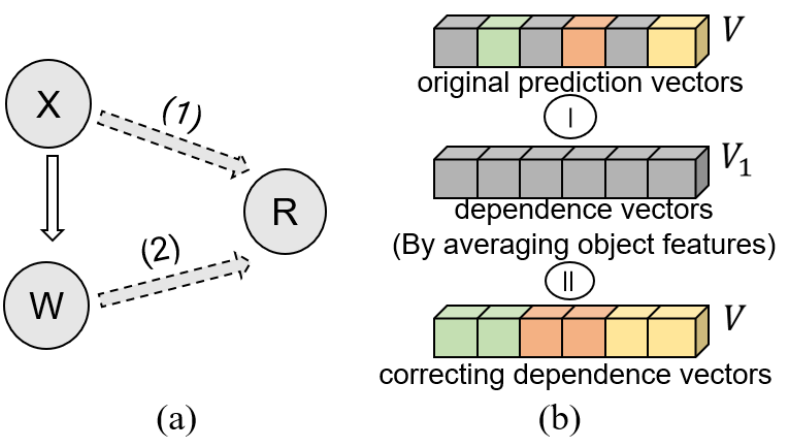
Figure 5. ( a ) Example of applying the object features and word vectors to predict object relationships, where X represents the visual features of the objects of interest, W represents the corresponding word vector in the external knowledge base, and R represents the prediction. ( b ) The process of adjusting the visual dependencies. The objective of this process is to preserve valid information while minimizing unrelated